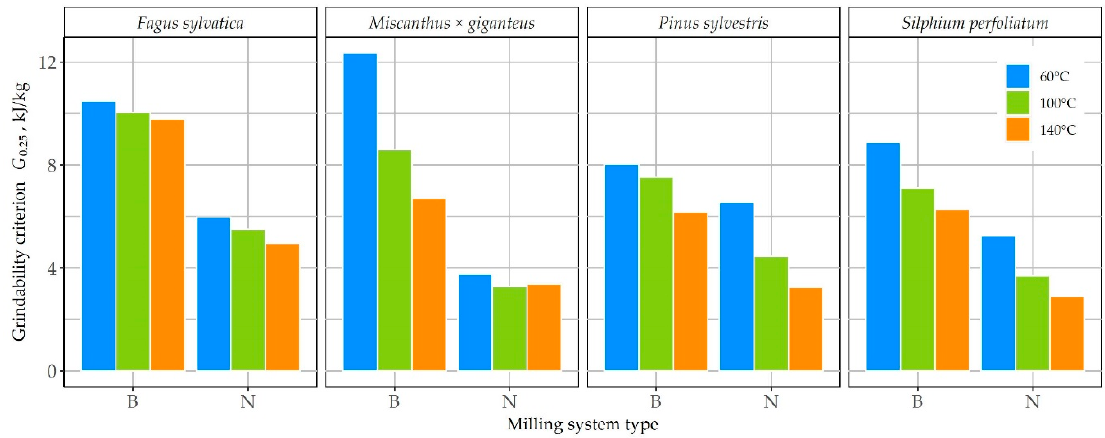
Figure 13. Values of grindability criterion; B is the hammer and N is the knife grinding system.